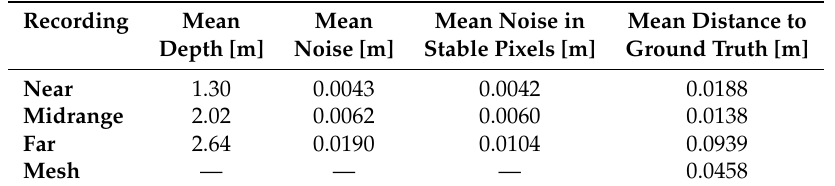
Table 3. Evaluation of a three-dimensional scene as depicted in Figure 5 captured by the HoloLens ToF sensor from three different distances regarding noise and accuracy against TLS ground truth. Additionally, a HoloLens triangle mesh of the scene is also evaluated against TLS ground truth. For visual representation of the results, see Figures 9–12.